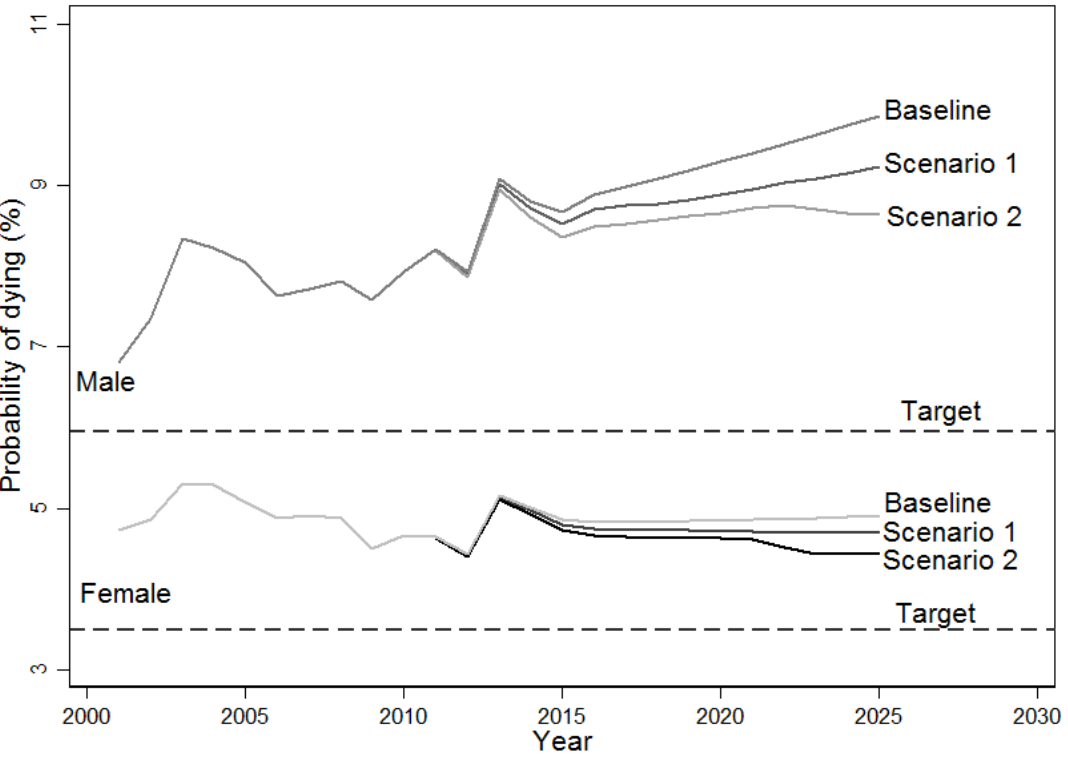
Figure 1. Probability of dying out of targeted NCDs among Thais aged between 30 and 70 by sex for baseline (no intervention) and ideal scenarios (10% alcohol use reduction). Table 1. Avoidable NCD deaths and percent in achieving the global target in 2025 of the study scenarios.